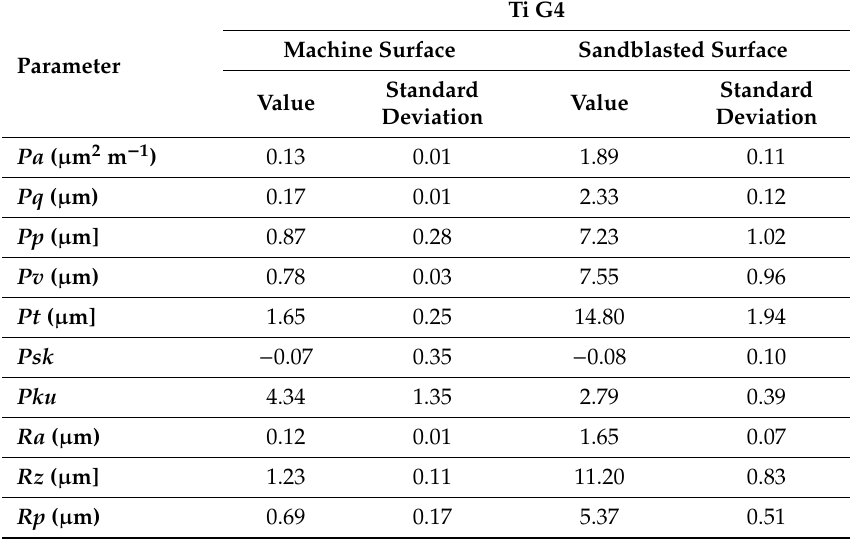
Table 6. Basic surface texture parameters for the Ti G4 with machine and sandblasted surface according to ISO 4287 [59], where: Pa –arithmetic mean deviation of the primary profile, Pq –root mean square deviation of the primary profile, Pp –maximum peak height of the primary profile, Pv –maximum valley depth of the primary profile, Pt –total height of the primary profile, Psk –skewness of the primary profile, Pku –kurtosis of the primary profile, Ra -arithmetic mean deviation of the roughness profile, Rz -maximum height of the roughness profile, and Rp -maximum peak height of the roughness profile. Ti G4 Machine Surface Sandblasted Surface Parameter Standard Value Value Deviation